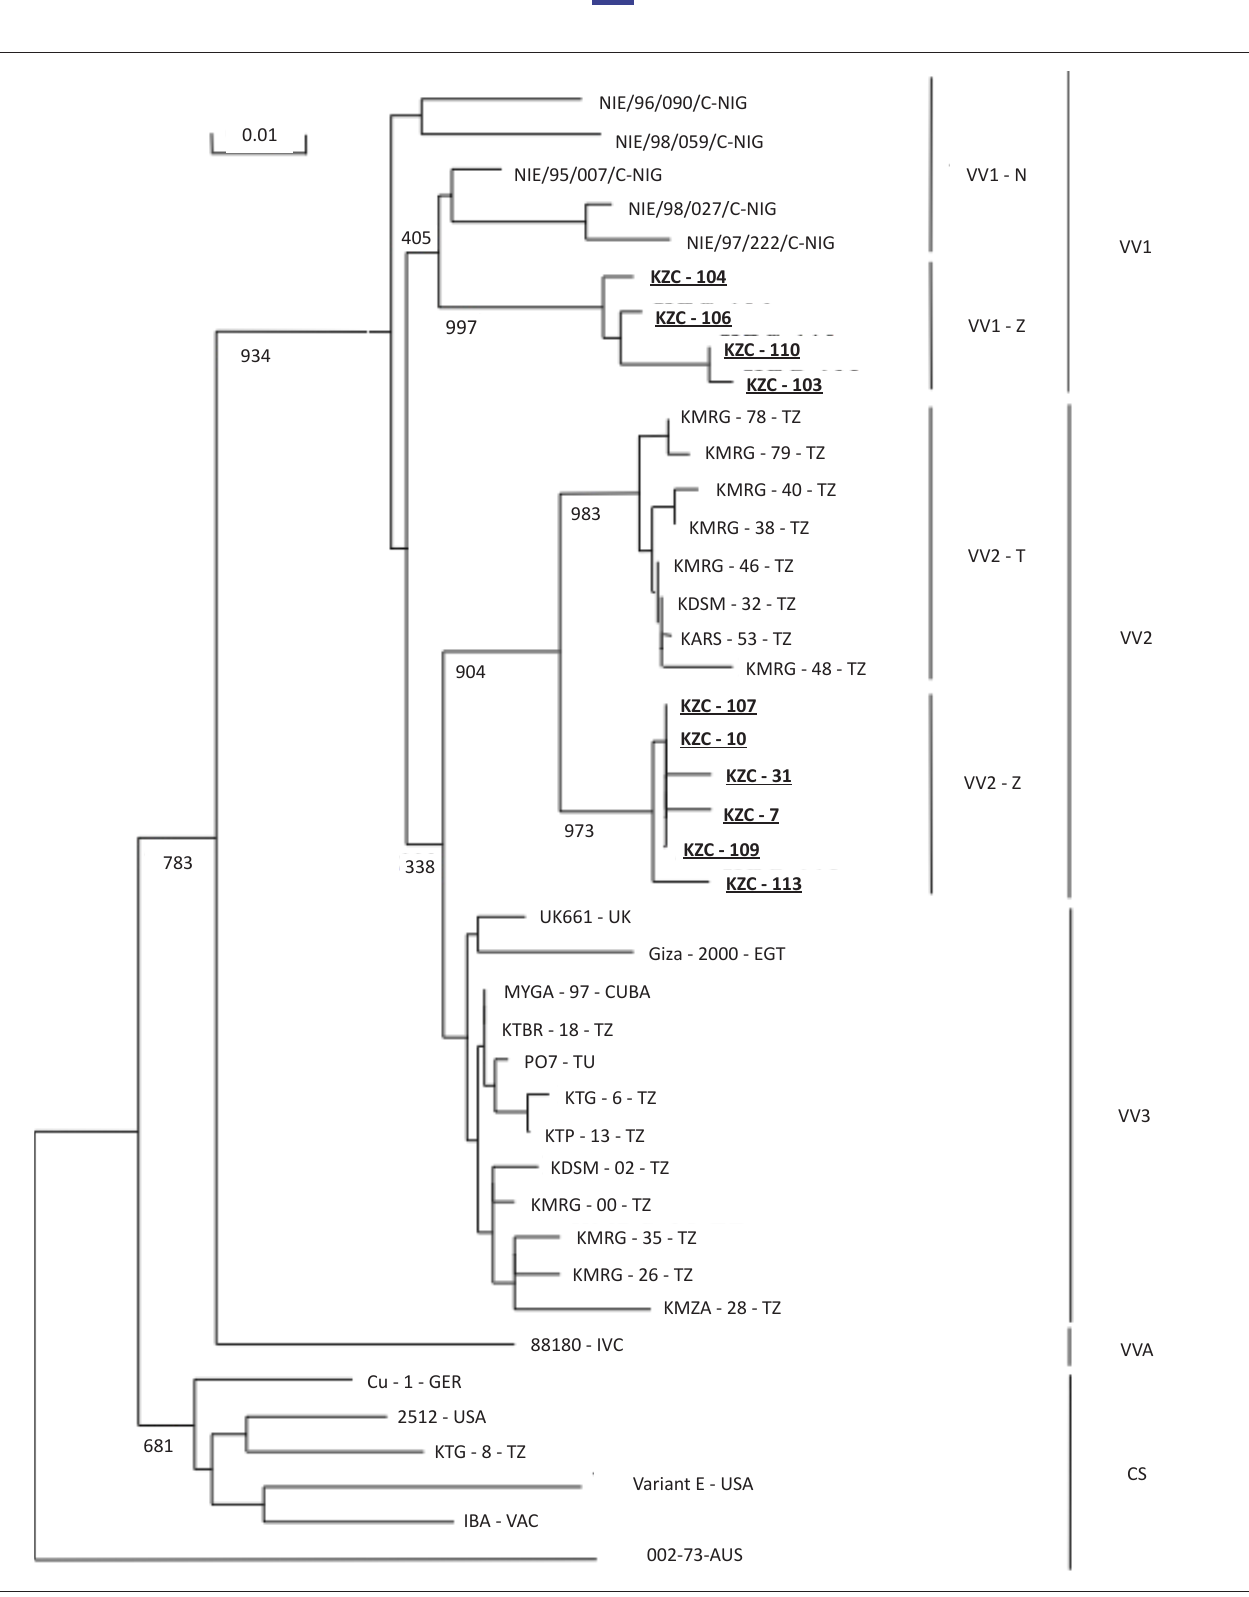
FIGURE 2. Phylogenetic tree calculated by the neighbour-joining method based on the VP2 hypervariable region of the capsid gene of infectious bursal disease virus serotype-1 strains, using nucleotide alignment created in Clustal W (version 1.8.3). The numbers at forks indicate the bootstrap values (1000 replicates) in important junctions of the